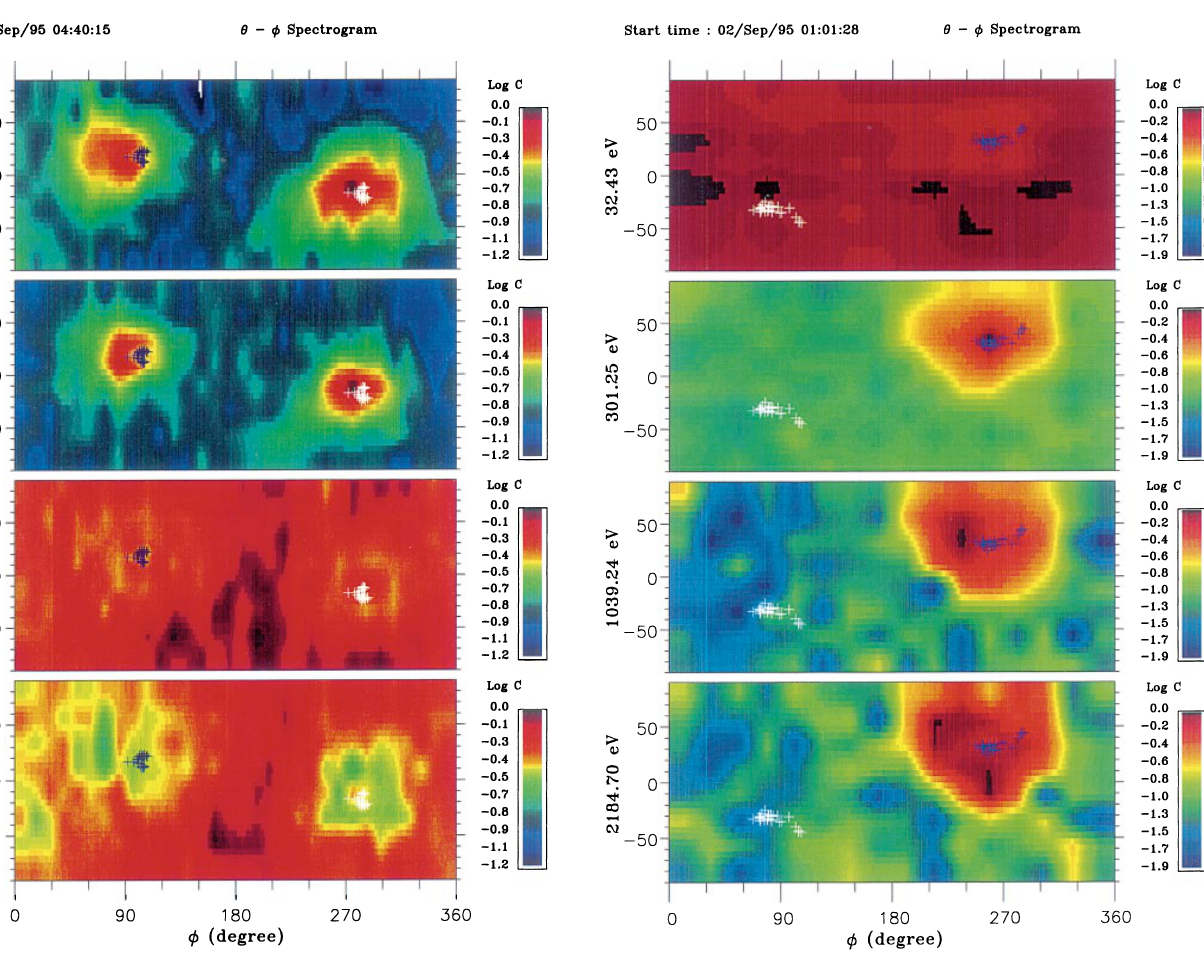
Fig. 8. Same as Fig. 6 but for unidirectional beams encountered in the magnetosheath on 2